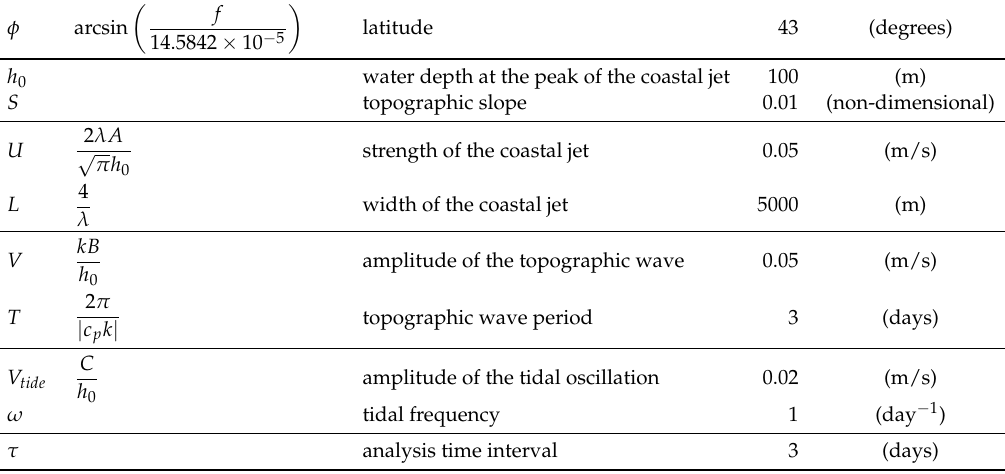
Table 1. Model parameters, definitions, physical meaning, base case values, and